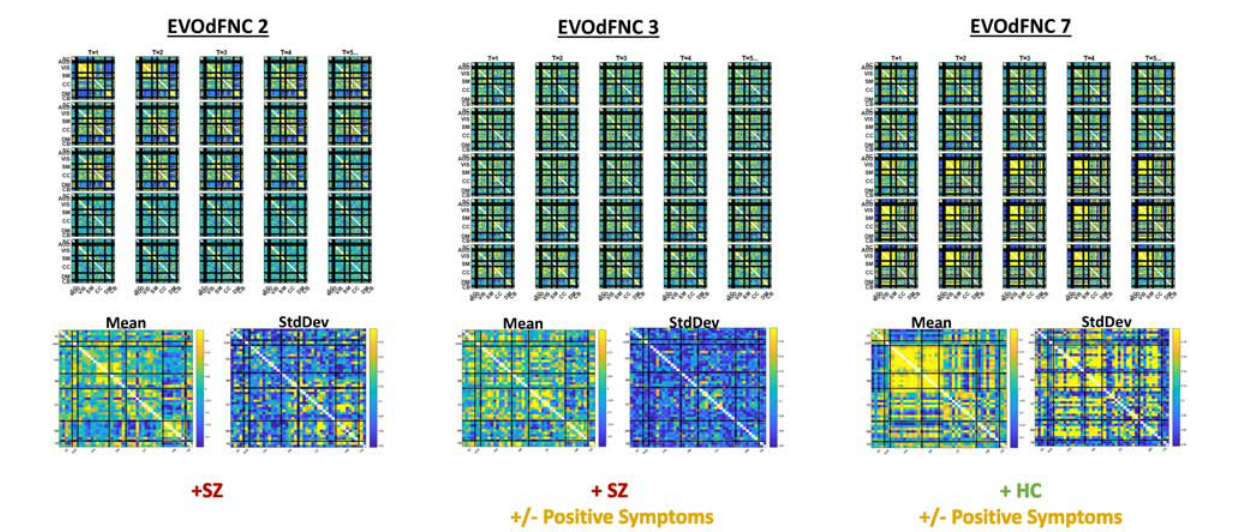
FIGURE 13 | Three EVOdFNCs (2, 3, and 7) start with intervals characterized by the modularized DMNneg patterning defined by SNAPdFNC State 3, a state that is more occupied by SZ patients. All three EVOdFNCs start with a DMNneg type of pattern, but each presents a different dynamic context. EVOdFNC 2 (top left) exhibits a high-contrast DMNneg pattern that dissolves into diffuse dysconnectivity. EVOdFNC 3 (top middle) presents a persistent, unvarying low-contrast DMNneg pattern. EVOdFNCs 2 and 3 have very similar temporal means (displayed below each EVOdFNC), with distinguishing characteristics requiring representation of their temporal evolution. Only EVOdFNC 3 has significant positive symptom effects. In EVOdFNC 7, the DMNneg pattern is part of a dynamic progression leading to AVSM-dominant hyperconnectivity. Although DMNneg patterning is significantly associated with SZ in time-blind SNAPdFNC analysis, EVOdFNC 7 not only has higher RI in HCs but also is sensitive to positive symptom levels in SZ patients.